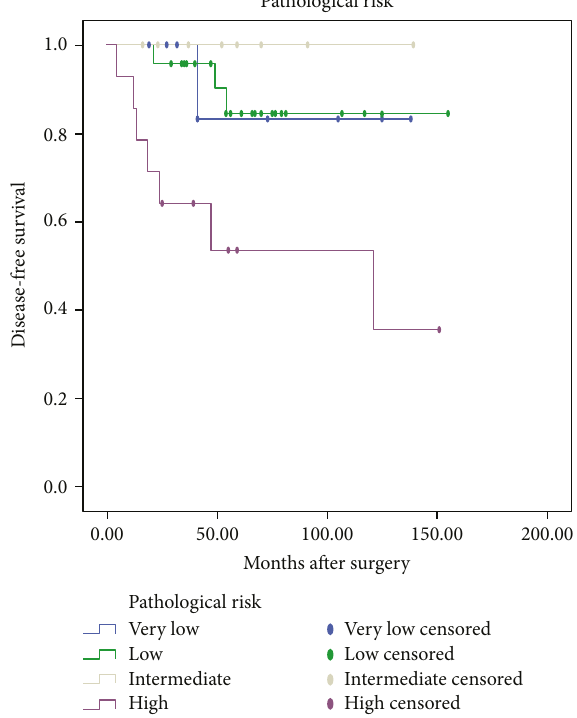
Figure 4: The Kaplan-Meier survival analysis reveals that the lower the pathological risk, the better the prognosis of duodenal stromal